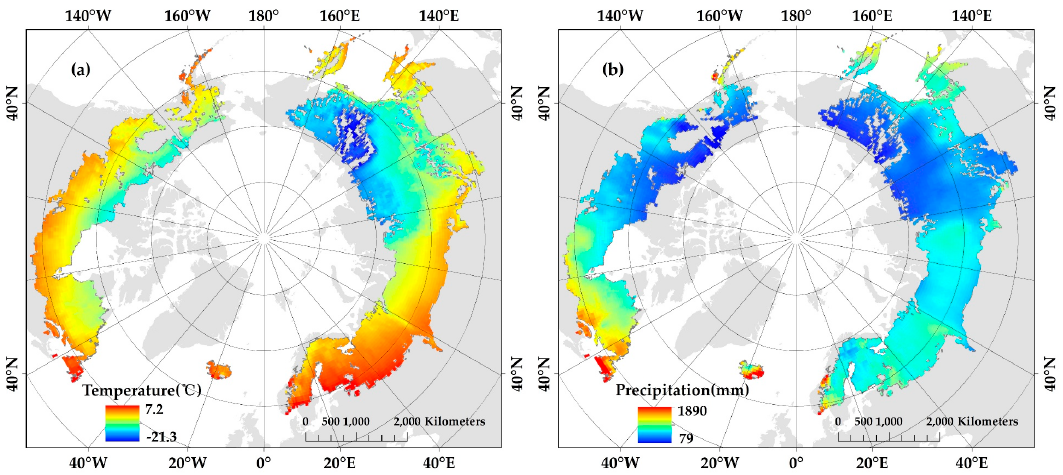
Figure 7. Description of the ( a ) annual mean temperature, ( b ) annual total precipitation in the boreal region.